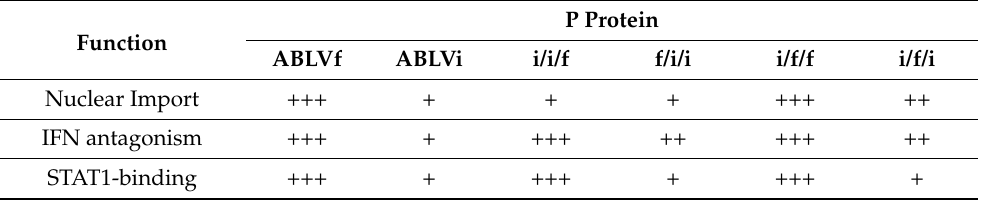
Table 1. Summary of the relative activity of ABLVf and ABLVi proteins and